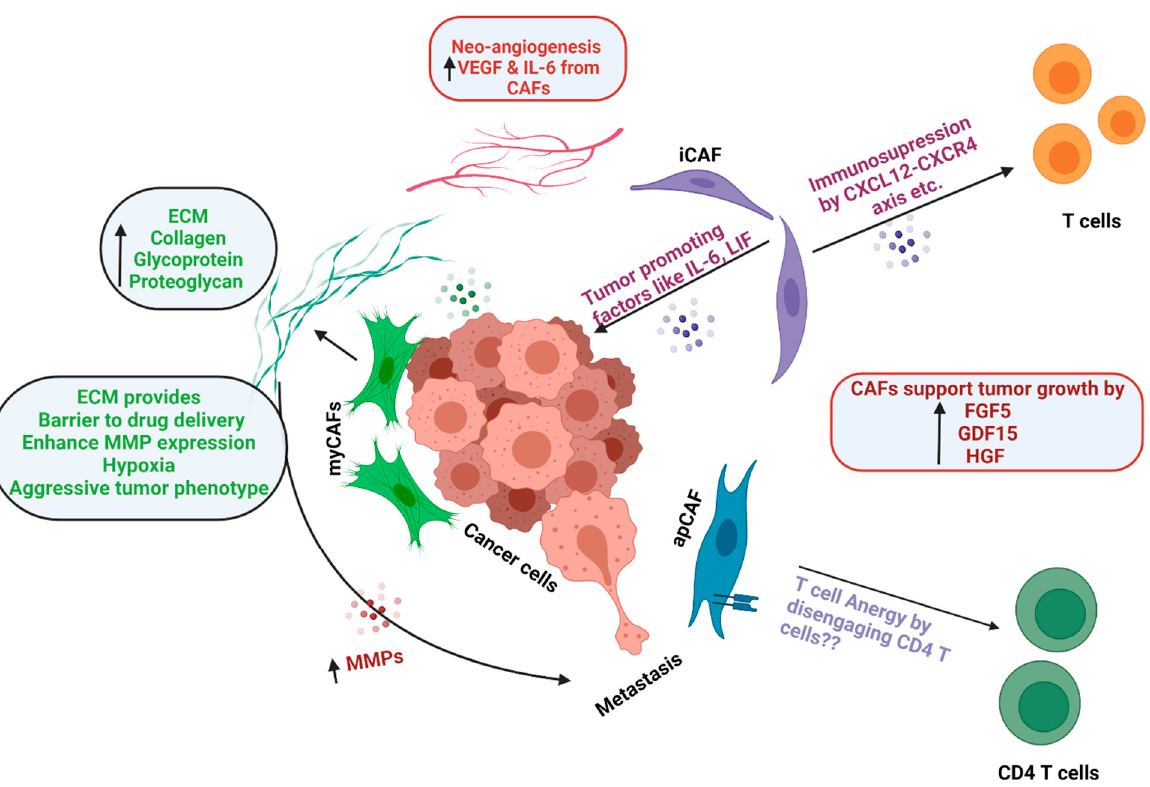
Figure 3. Functions of CAFs. Schematic representation of the functions of CAFs in the tumor microenvironment, such as ECM deposition, immunosuppression, tumor promotion, neoangiogenesis, metastasis, etc.